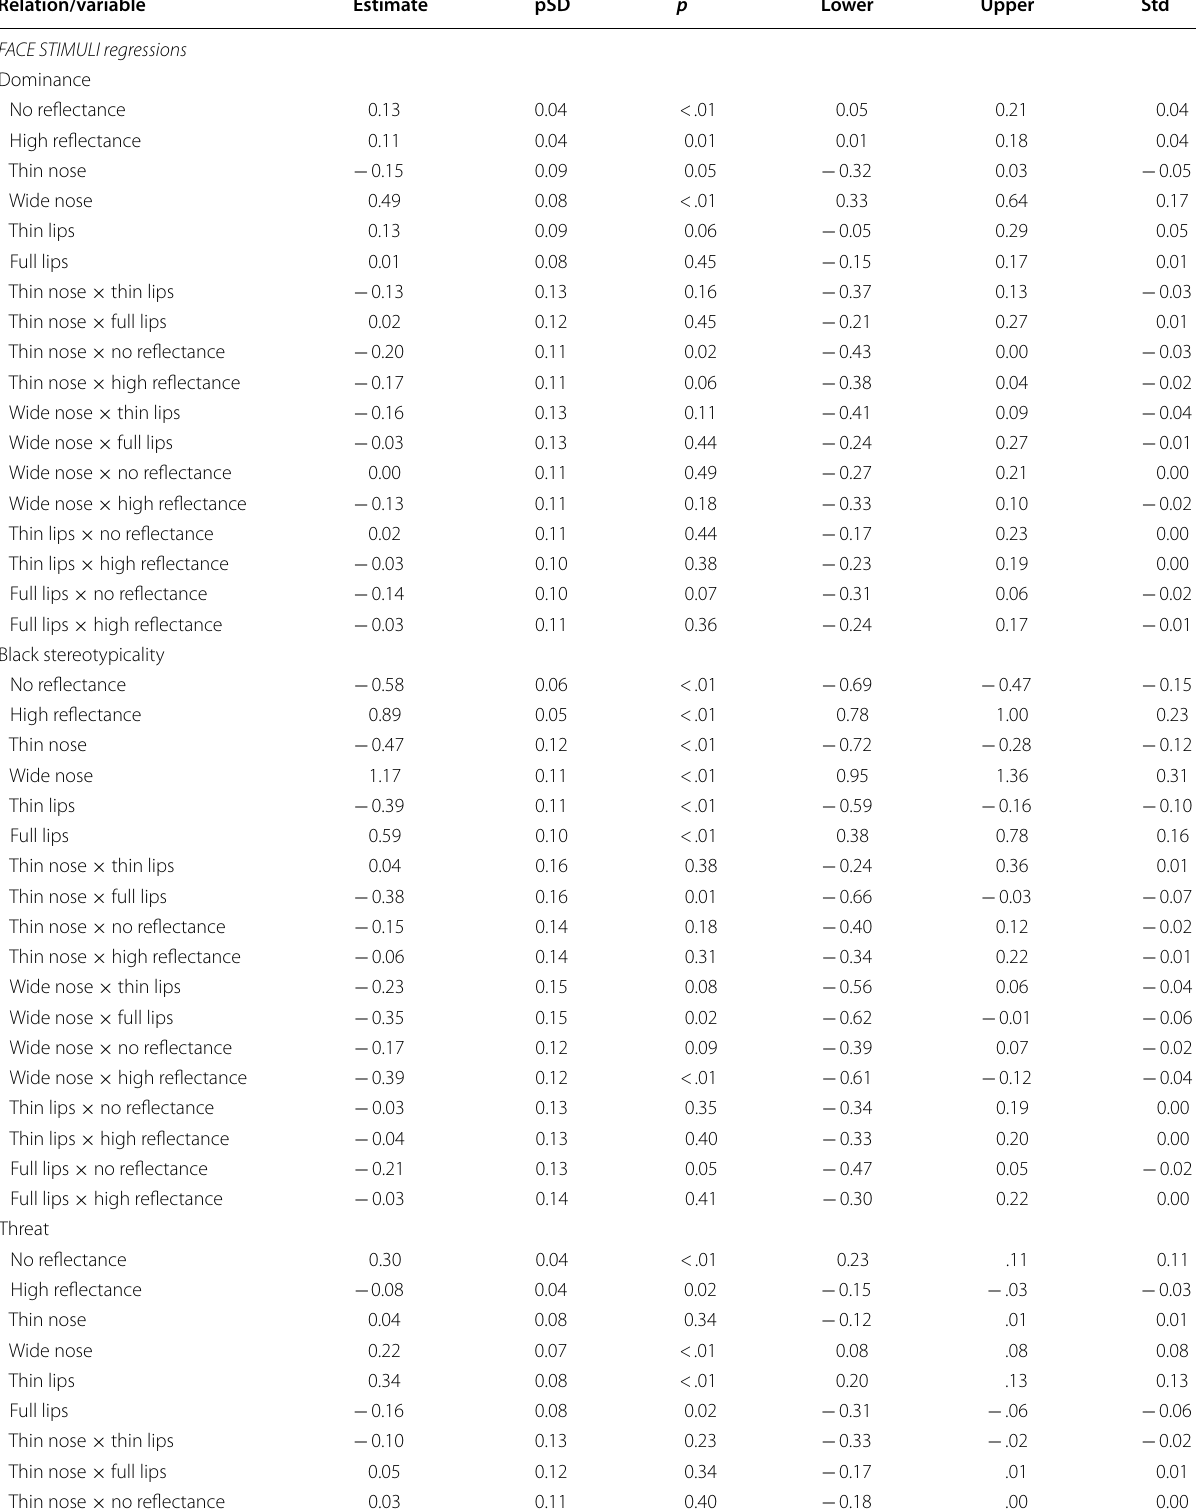
Table 2 Parameter estimates for level 1 of the two‑level model